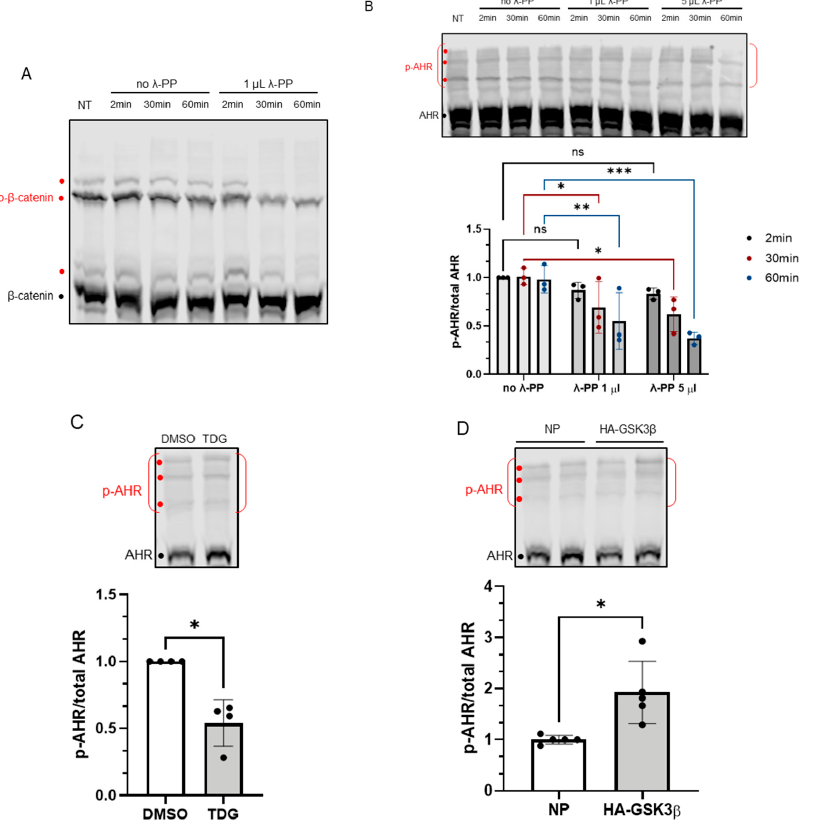
Figure 4. Phosphorylation of AHR is affected by GSK3 β activity. 7.5% acrylamide bis-Tris gel embedded with 20 µ M phos-tag reagent was used to confirm the phosphorylation of AHR. ( A ) Phosphorylated (p- β -catenin) and unphosphorylated β -catenin can be separated, and the intensities of three phosphorylated bands (red dots) were noticeably decreased by 1 µ L (80 units) of λ -PP treatment for 2, 30 or 60 min at 30 ◦ C. NT represents no treatment. The top region of AHR blot in ( B – D ) shows three prominent phosphorylated AHR bands (p-AHR, red dots). The whole top region indicated by the red bracket is defined as the phosphorylated region and unphosphorylated AHR is indicated with the black dot. The y-axis (p-AHR/total AHR) represents intensity of the phosphorylated bracket region divided by the sum of the intensities of the bracket region plus unphosphorylated AHR. ( B ) Time- and dose-dependent decrease of the p-AHR/total AHR value after 1 µ L (80 units) or 5 µ L (400 units) of λ -PP treatment for 2, 30 or 60 min for 30 ◦ C. The images are representative of the replicate data (means ± SD, n = 3, * p < 0.05, ** p < 0.01, *** p < 0.001, ns represents not significant). Two-minute of no λ -PP treatment group was arbitrarily set as one (with no error bar) for data normalization. Two-way ANOVA with Dunnett multiple comparisons test was performed to determine statistical significance. ( C ) After 40 µ M TDG treatment for 8 h, the p-AHR/total AHR values decreased. The images are representative of the replicate data (means ± SD, n = 4, * p < 0.05). DMSO group (treated for 8 h) was arbitrarily set as one (with no error bar) for data normalization. Unpaired t -test with Welch’s correction was used to determine the statistical significance. ( D ) Transient expression of HA-GSK3 β increased the p-AHR/total AHR value. The images are representative of the replicate data (means ± SD, n = 5, * p < 0.05). No plasmid group (NP), which represents cells undergone same transient transfection protocol without the plasmid carrying HA-GSK3 β cDNA, was arbitrarily set as one for data normalization. Unpaired t -test with Welch’s correction was used to determine the statistical significance. For A to D, each Western lane contained 40 µ g of whole-cell lysate. Data were normalized by total protein